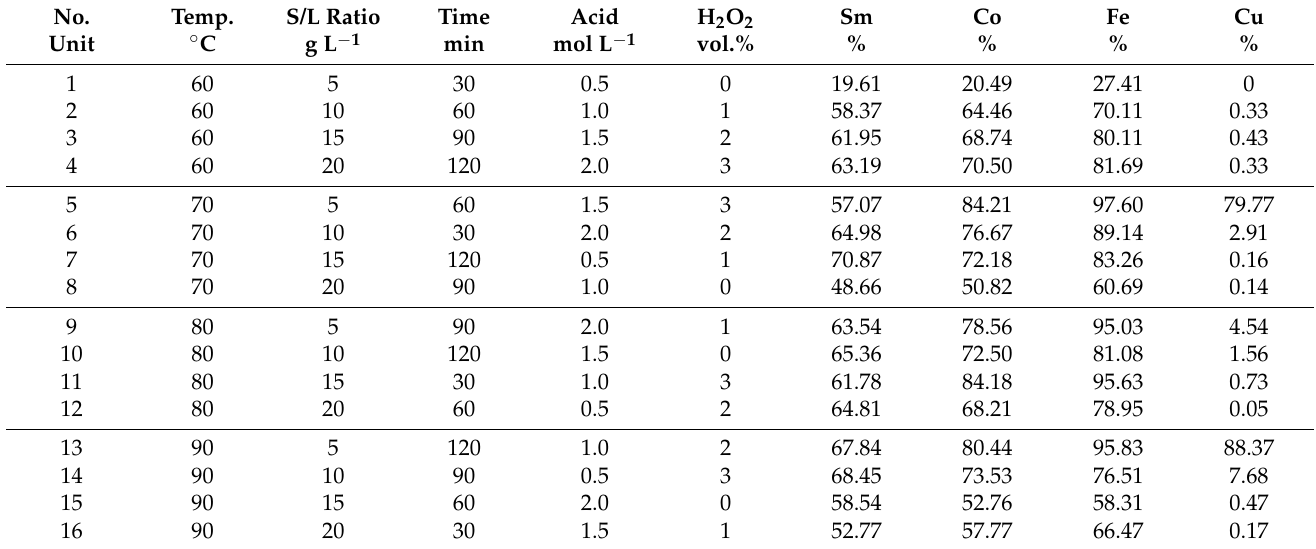
Table 3. Citric acid leaching rates of Sm, Co, Fe, and Cu under different control factors.